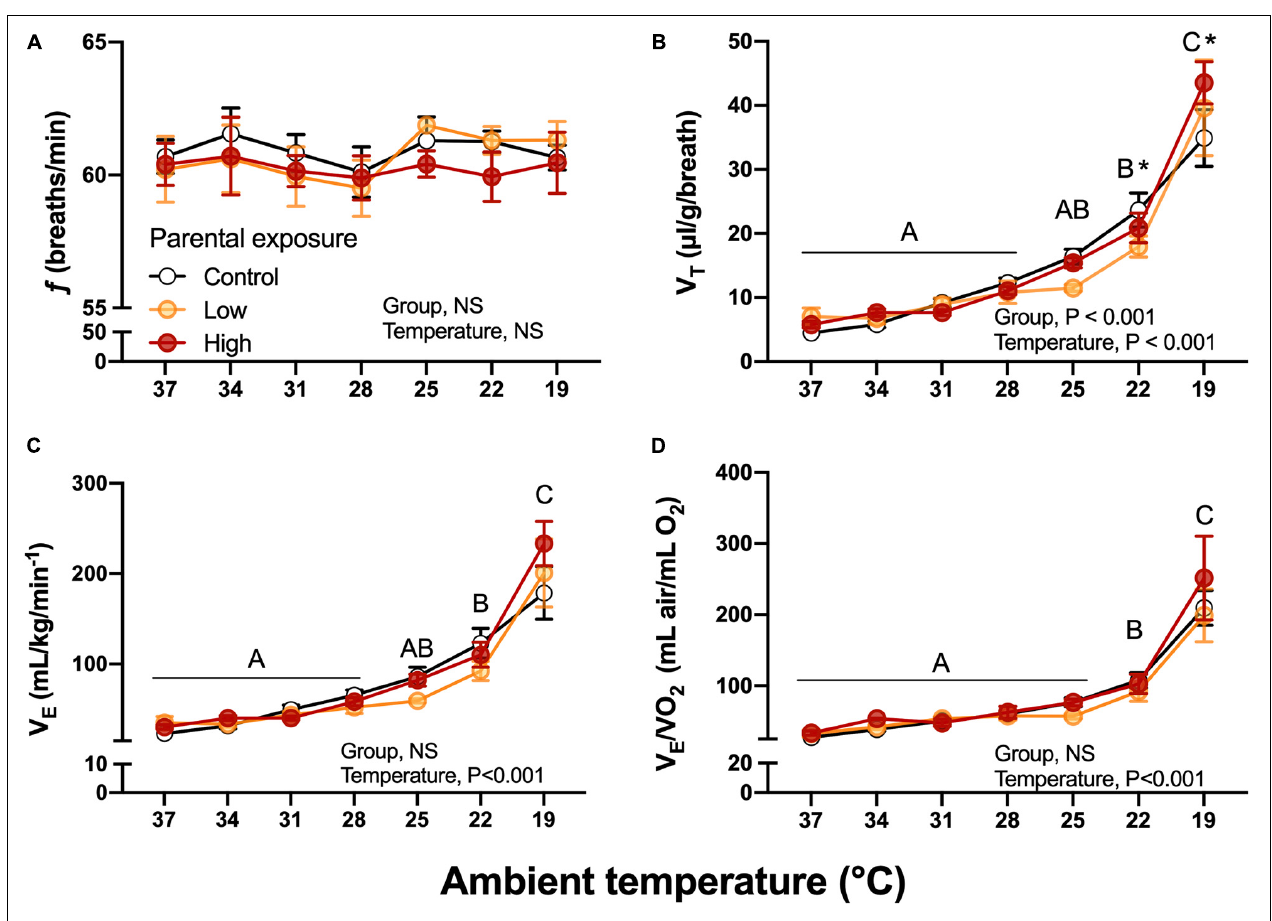
FIGURE 7 | Ventilatory variables as a function of declining ambient temperature in 7–8 day old king quail hatchlings (F 1 ) derived from parents (P 0 ) exposed to control conditions or low or medium oil exposure through diet. (A) Breathing frequency ( f ). (B) Tidal volume (V T ). (C) Minute ventilation (˙V E ). (D) Air convection requirement (˙V E /˙VO 2 ). Data are expressed as mean ± 1 standard error of the mean. Different letters indicate statistically significant differences between temperatures. “*” indicate statistical differences between the groups at the specified temperature. n = 4–8 per data